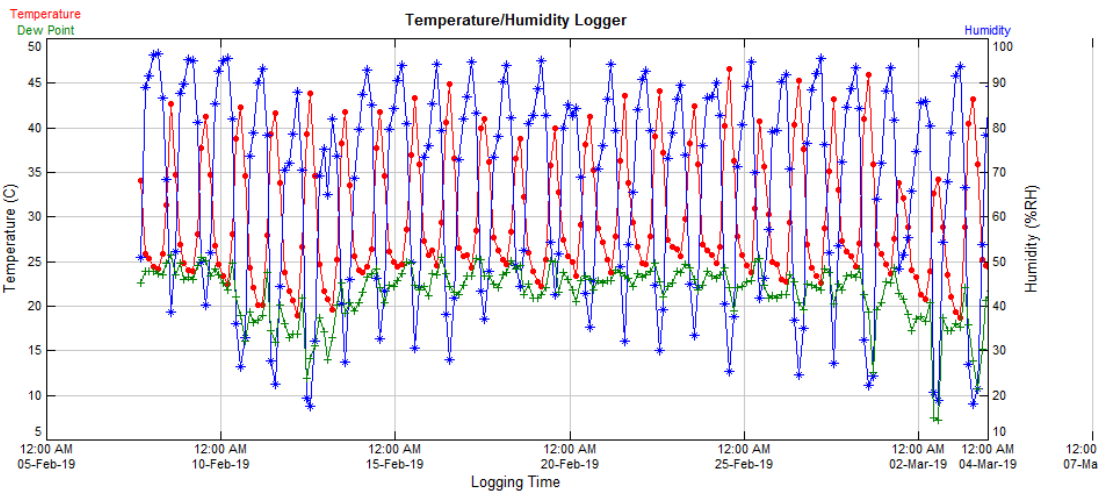
Figure 1. A graph of temperature-humidity-dew conditions from the vegetative growth to the post- flowering period of common bean in a screen-house, obtained using a Supco ® data logger sensor.